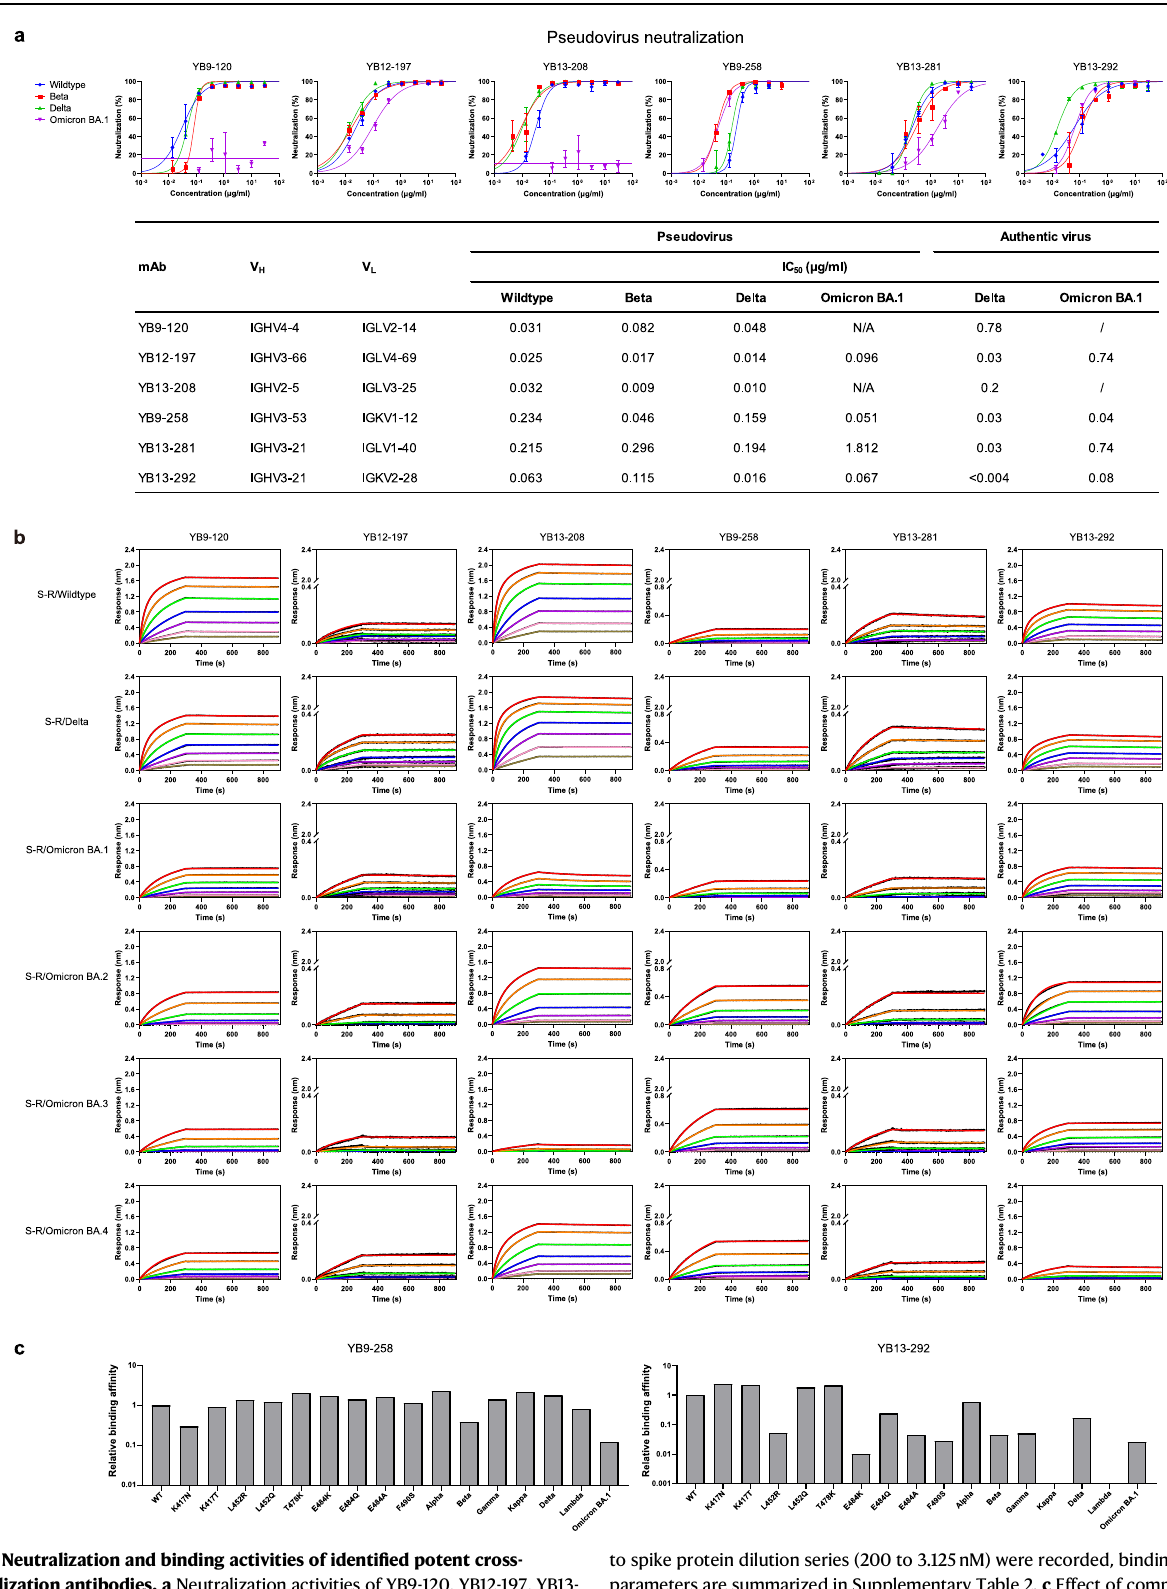
to spike protein dilution series (200 to 3.125nM) were recorded, binding kinetics parameters are summarized in Supplementary Table 2. c Effect of common SARS- CoV-2 RBD mutations on YB9-258 and YB13-292 binding. Fold changes are nor- malized to K D s calculated from binding curves to wildtype RBD (RBD binding curvesareshowninSupplementaryFig.3a,band K D datausedforcomparisonsare shown in Supplementary Table 3). Source data for a are provided as a Source Data fi